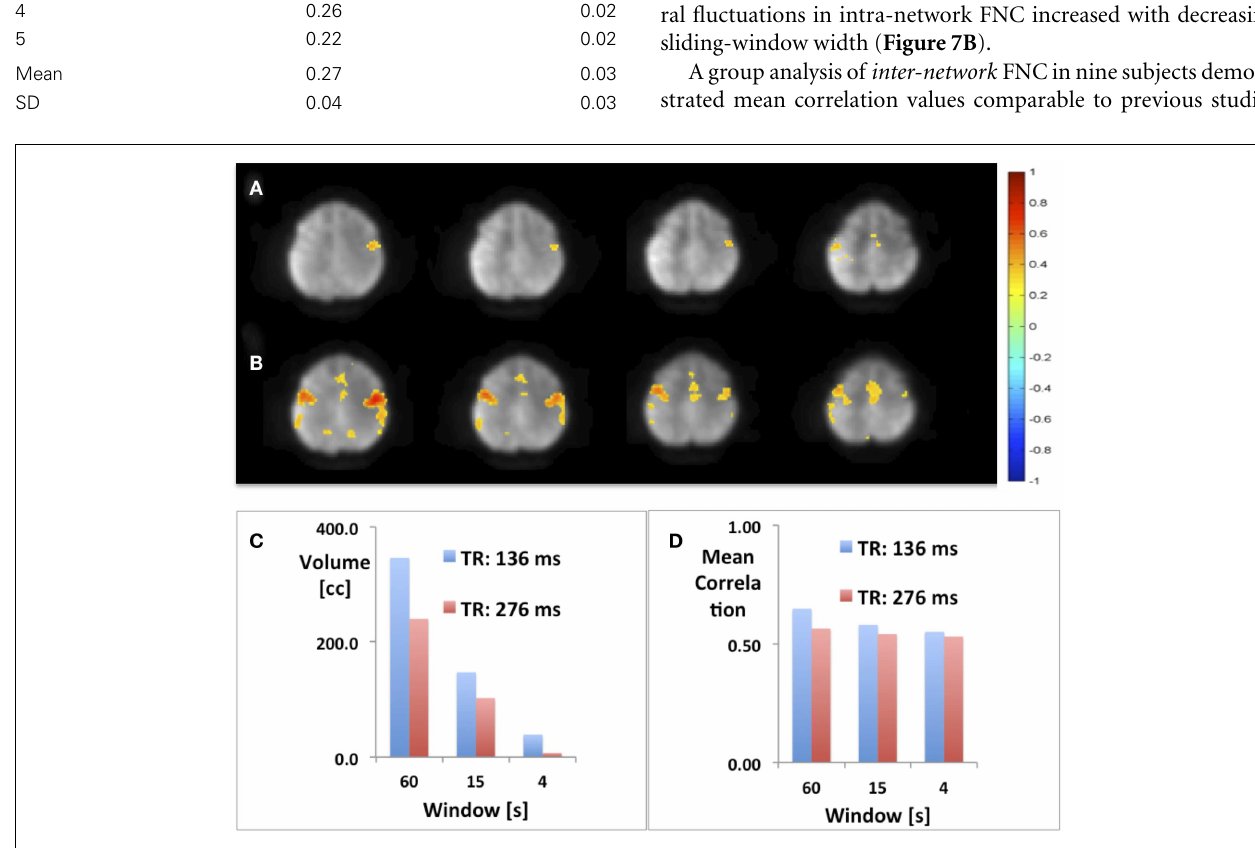
FIGURE 2 | Seed-based mapping with 4s sliding window of the sensorimotor RSN comparing (A) MEVI4 (TR: 286ms) and (B) MEVI2 (TR: 136ms), which shows higher peak correlation and larger spatial extent of connectivity across the two-slab volume compared with